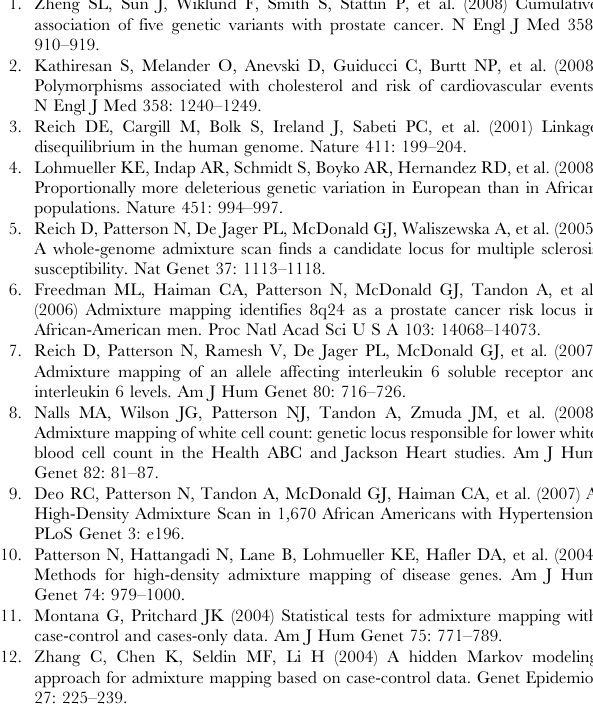
bold). The percent change in TG level per LPL allele is shown with standard error (SE) for the total population (effect_all), JHS-AFR- and JHS-EUR-2 LPL (f_eur) are also shown, as well as the chromosomal position in bases on chromosome 8.